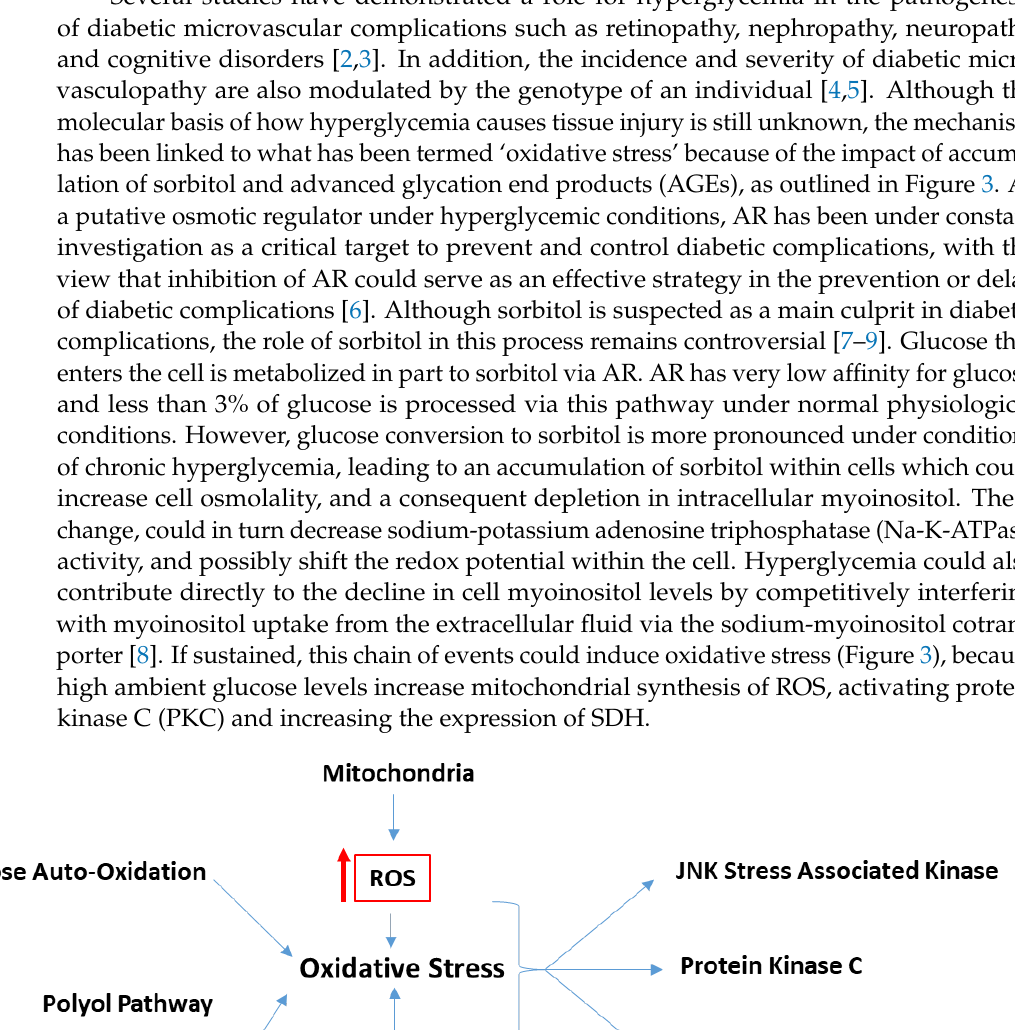
Figure 4. Chemical structure of major substrates metabolized by aldose reductase (AR) enzyme. ( a ). Acrolein (prop-2- enal), ( b ). HNE ((E)-4-hydroxynon-2-enal), ( c ). Glyoxal (oxaldehyde), ( d ). Methylglyoxal (2-oxopropanal), ( e ). ONE ((E)- 4-oxonon-2-enal), ( f ). Glucose (6-(hydroxymethyl) oxane-2,3,4,5-tetrol), ( g ). Galactose ((3R,4S,5R,6R) -6-(hydroxymethyl) oxane-2,3,4,5-tetrol).